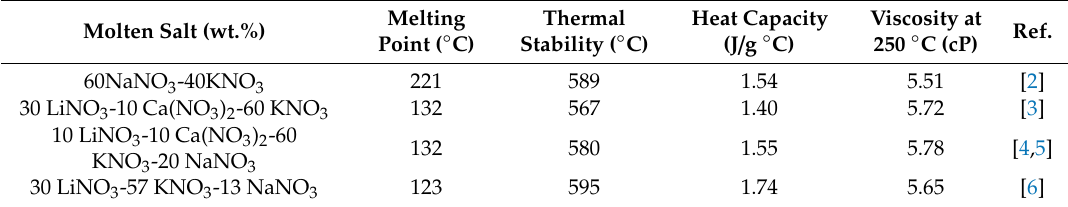
Table 1. Thermal properties obtained in molten salts with LiNO 3 / Ca(NO 3 ) 2 additions compared with solar salt.